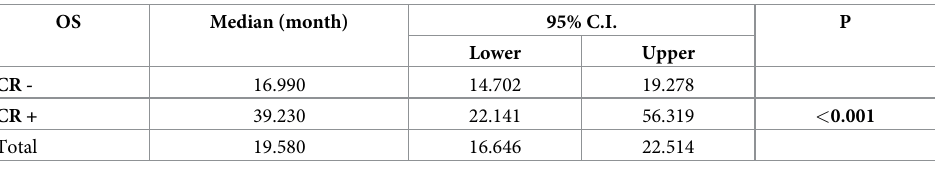
Table 2. Overall survival analysis based on whether a complete response was